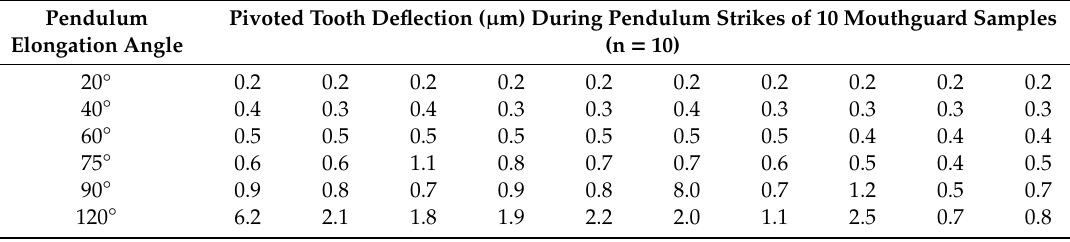
mouthguard 10: 40.6 µ m. Whereas other mouthguard values from this angle range from 17.2–29.6 µ